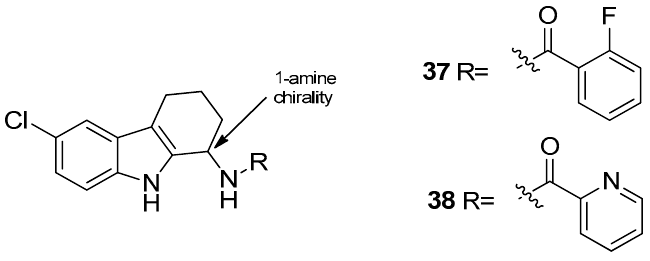
Figure 17. Structures of tetrahydrocarbazole amides 37 – 38 .